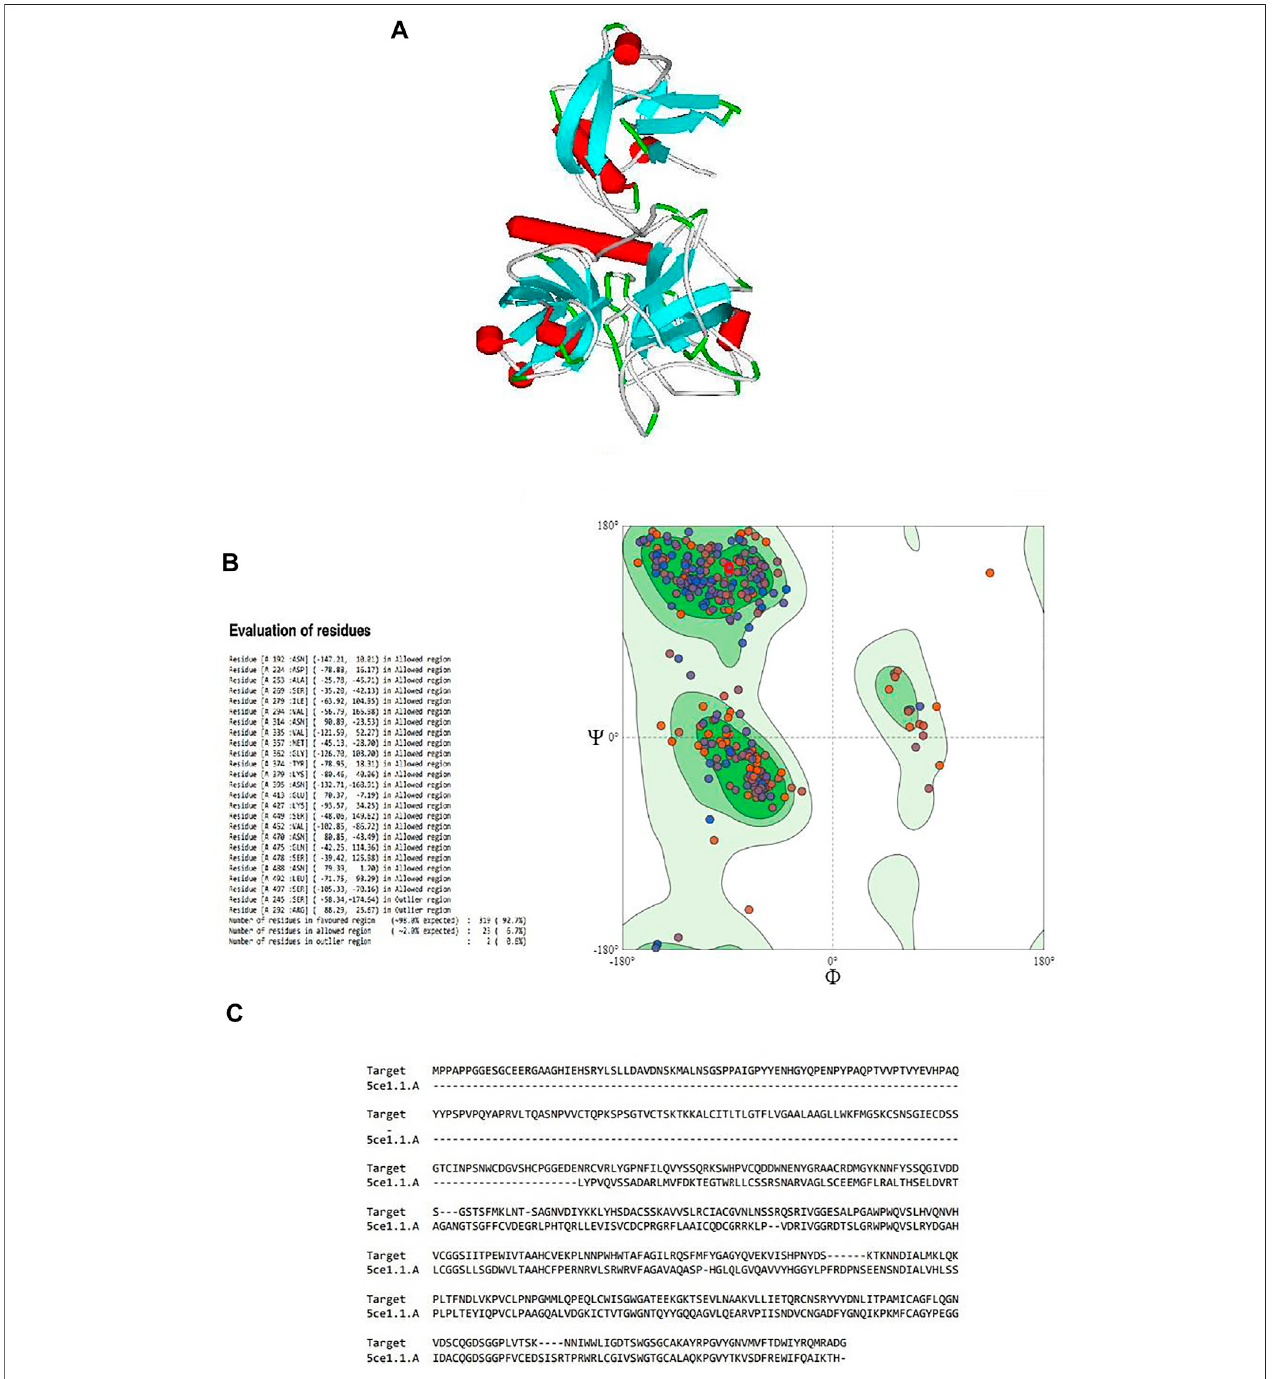
FIGURE 1 | (A) Three-dimensional structure of the modeled serine protease transmembrane protease serine 2 (TMPRSS2), (B) Ramachandran plot validation of the modeled 3D structure, (C) alignment of the target serine protease TMPRSS2 and the template serine protease hepsin (PDB ID: 5CE1.A.).